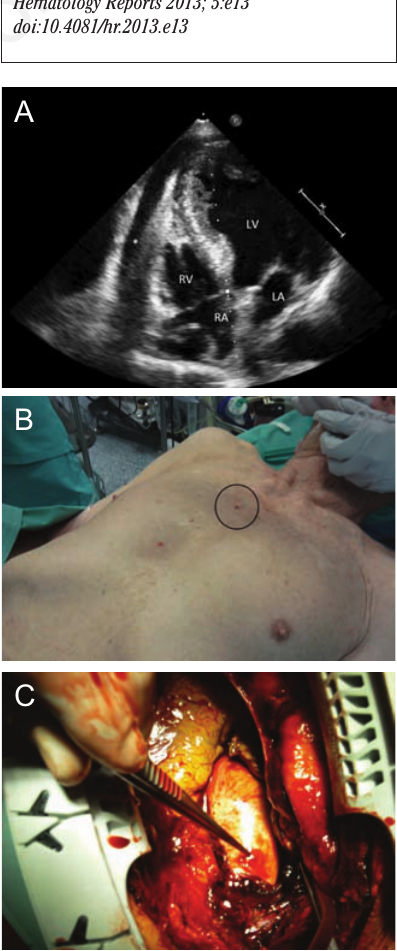
Figure 1. A) Computed tomography scan. RA, right atrium; RV, right ventricle; LA, left atrium; LV, left ventricle; asterisk, pericardial effusion. B) Site of bone marrow biopsy puncture (encircled). C) Site of ascending aorta stab injury (showed by